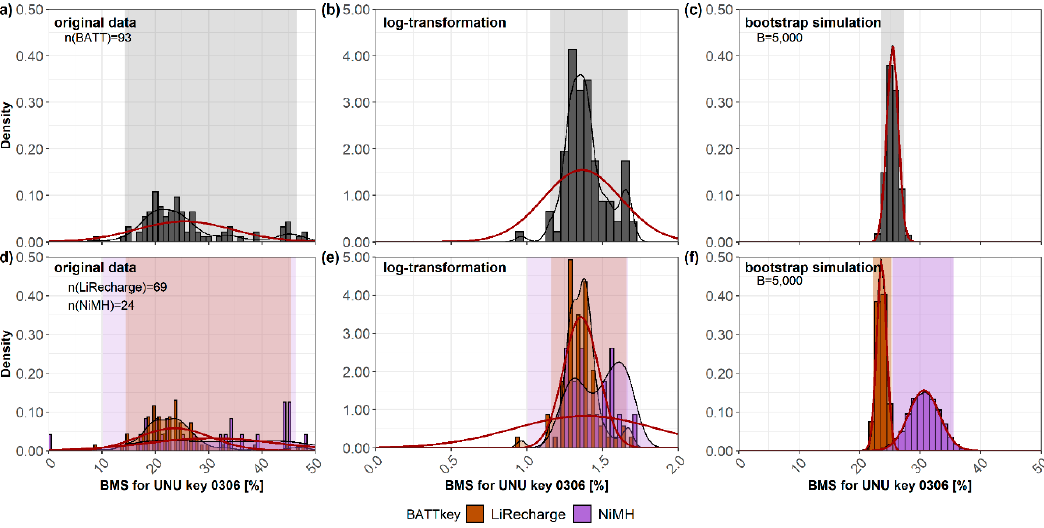
Figure 6. Histogram and density distribution for the battery mass share (BMS) of LiRecharge and NiMH for mobile phones (UNUkey 0306). Original data ( a , d ), log-transformed data ( b , e ), and bootstrap sample means with B = 5000 ( c , f ). The (log-)normal distribution curve for the sample mean and SD is shown in dark red. The 95% CI* is drawn as a semi-transparent area in the corresponding BATTkey color.